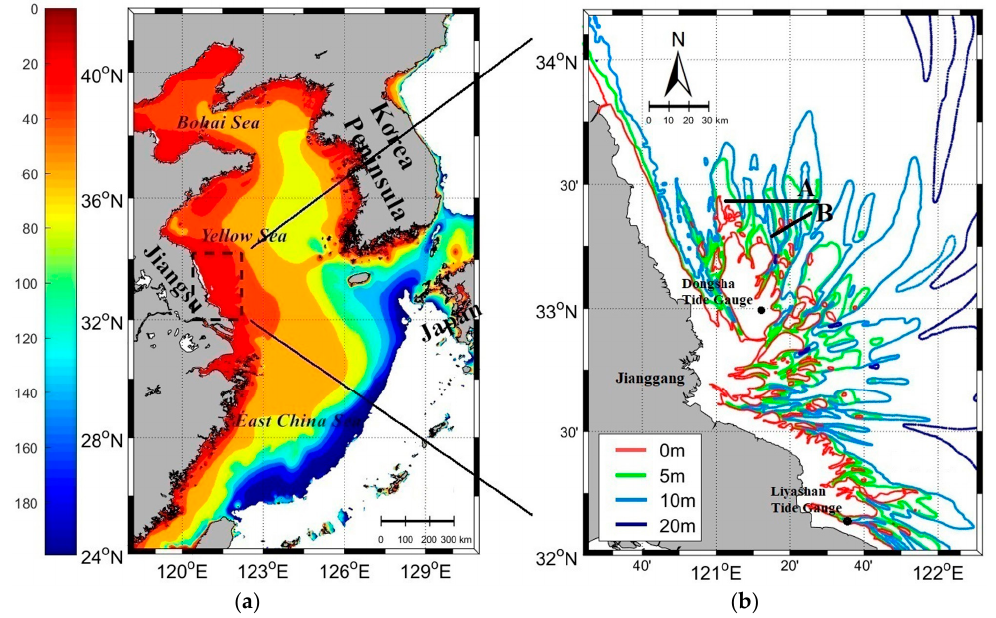
Figure 1. ( a ) Bathymetry (m) of the Yellow Sea and ( b ) Subei Bank boarded by dashed lines in panel ( a ). The bathymetry data are from ETOPO2 (National Centers for Environmental Information, 2006) for ( a ) and Sea Chart (published by China Navy Hydrographic Office, 2013) for ( b ). The cross sections A and B in ( b ) (black lines) are primarily perpendicular to the paralleled bright stripes on SAR imagery in Figure 2. The black dots denote the locations of the Dongsha and Liyashan tide gauges.